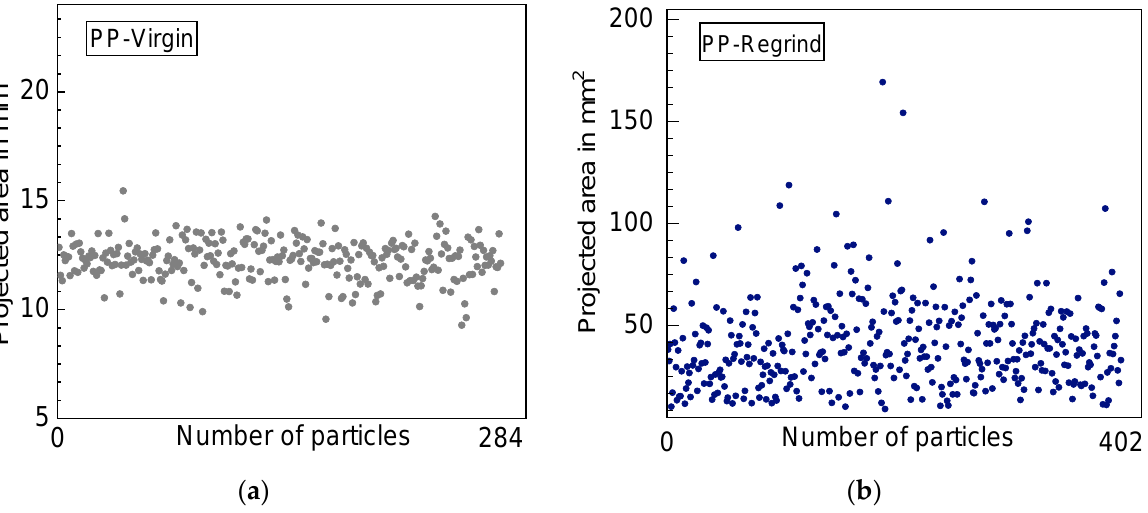
Figure 4. Projected area of ( a ) the virgin PP granule ( b ) the regrind PP material determined by using a flatbed scanner.